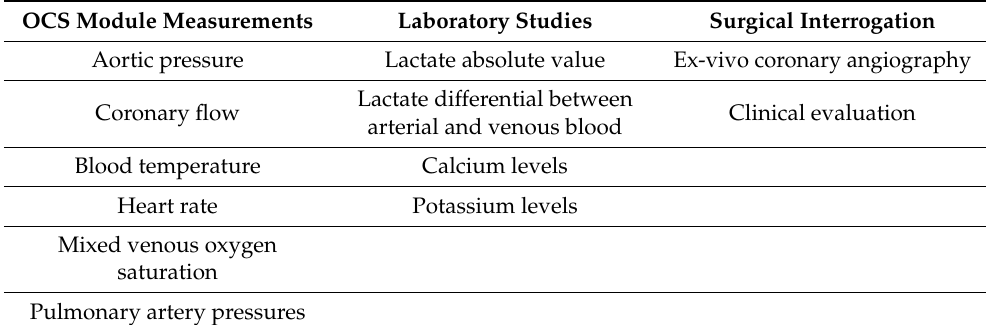
Table 1. Allograft assessment